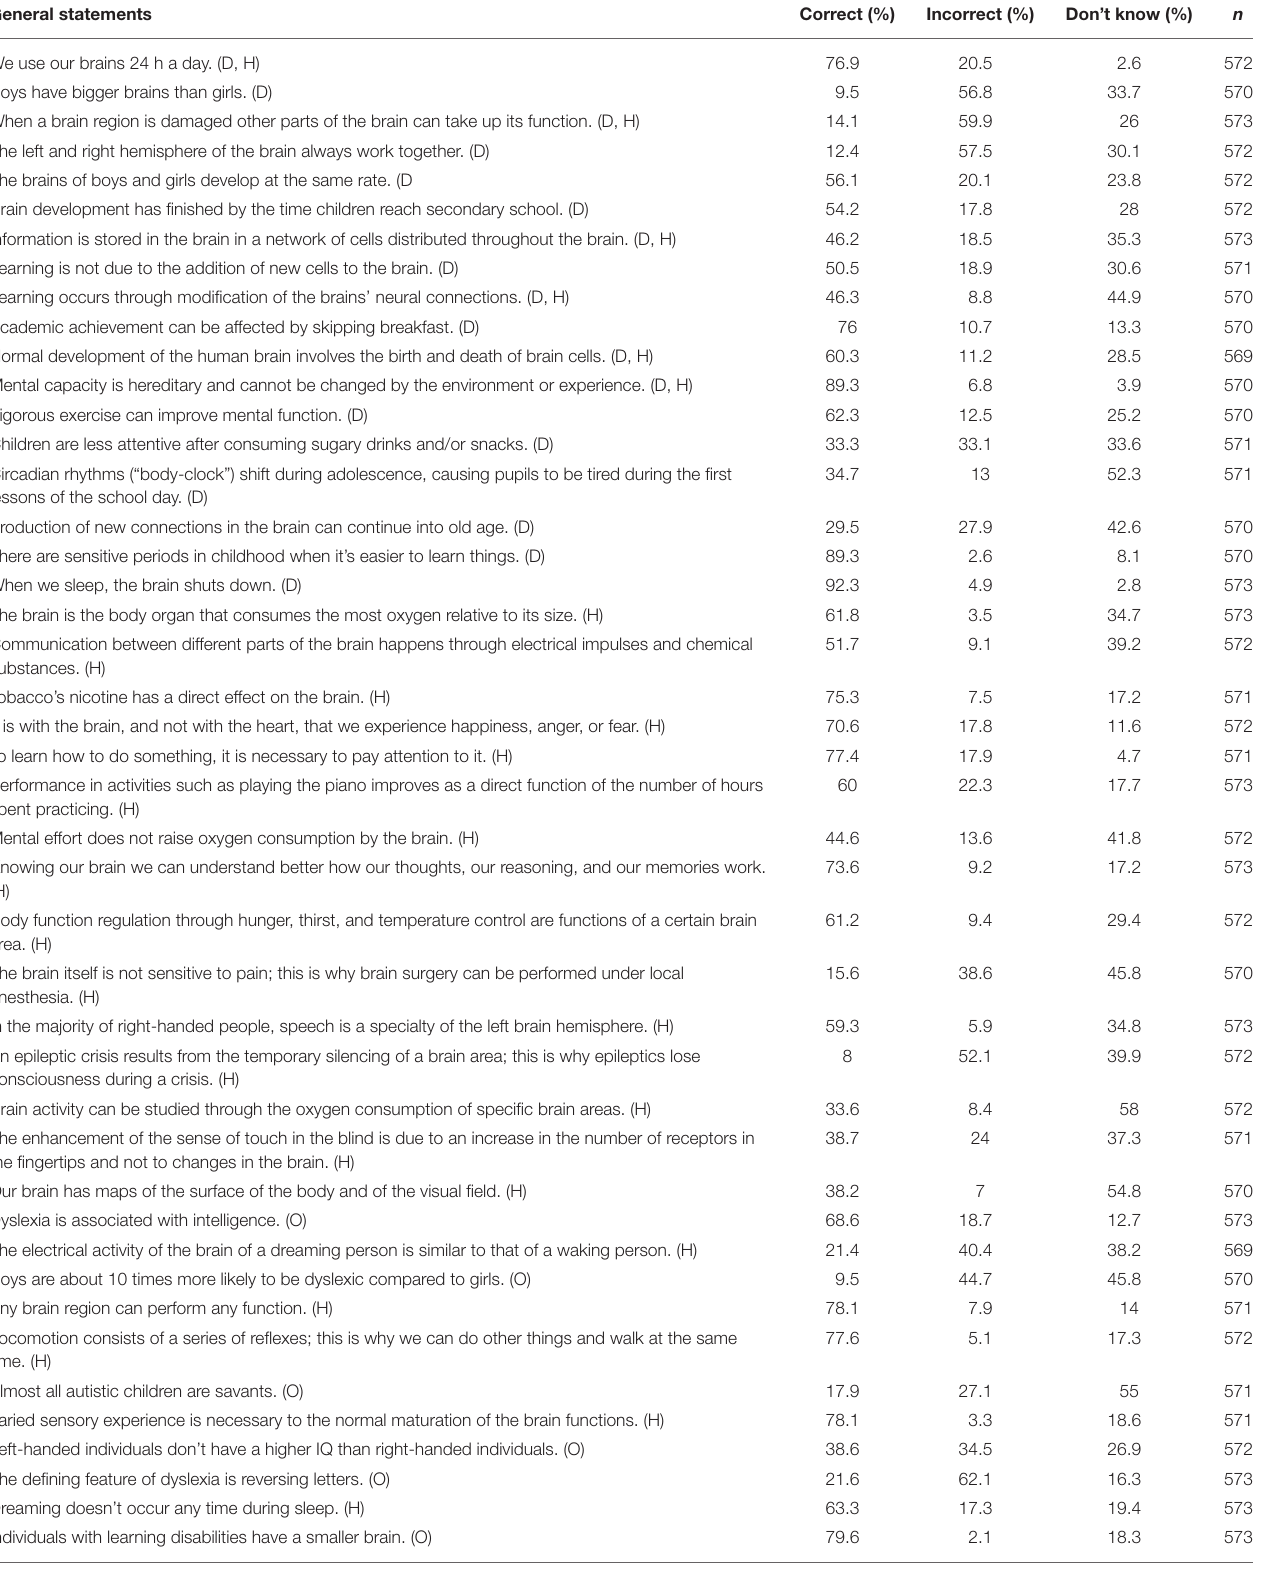
TABLE 2 | Correctness of responses for general